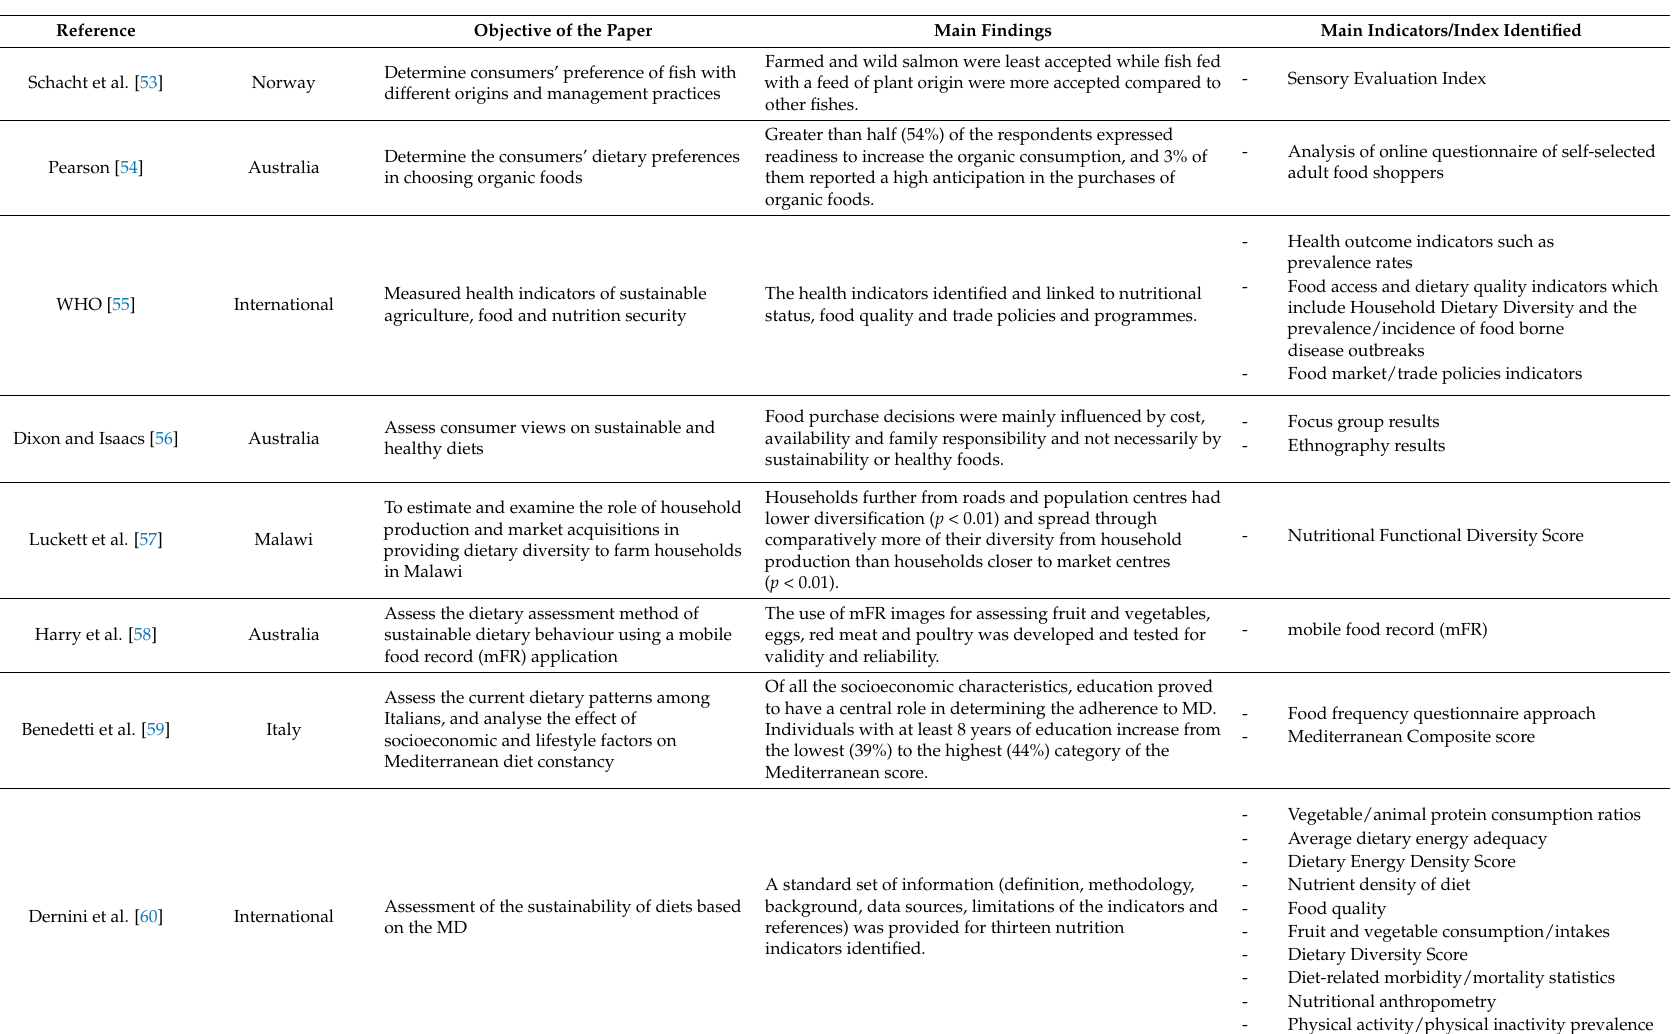
Table 2. The nutrition and health indicators used for assessing a sustainable